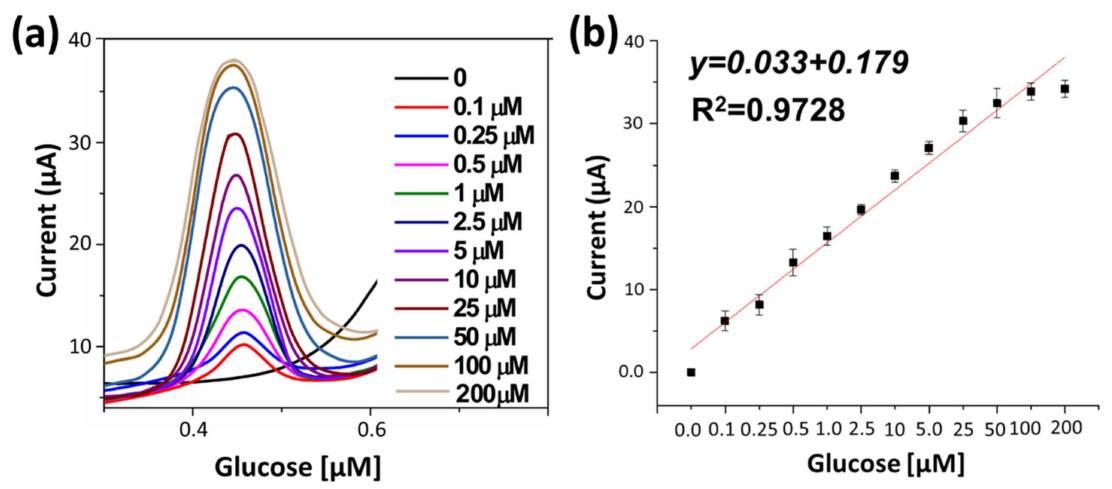
Figure 4. ( a ) Differential pulse voltammogram (DPV) of developed NEGS with different concentration glucose in 0.1 M NaOH (pH 13), ( b ) Calibration curve (current vs. glucose concentration).